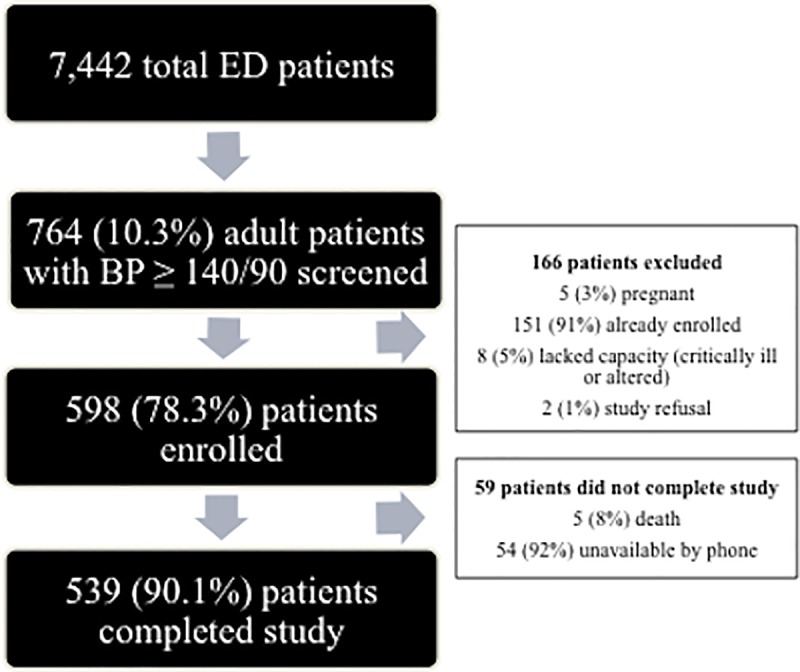
Study enrollment.